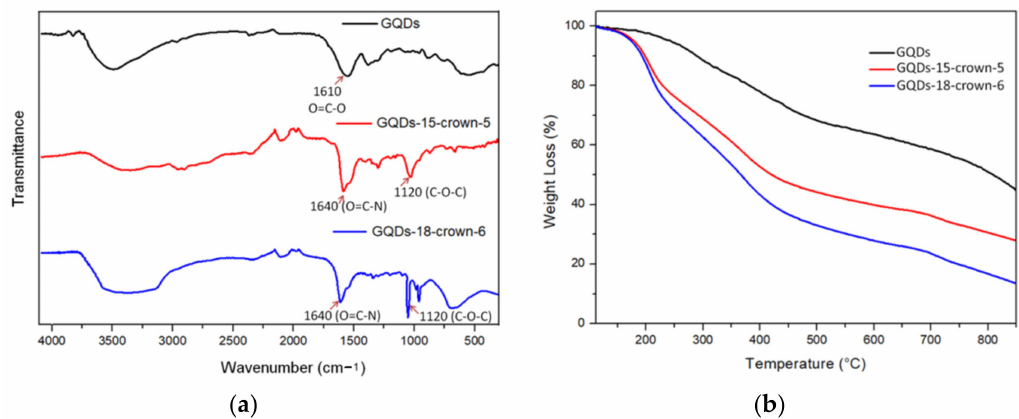
Figure 1. ( a ) FTIR spectra of the starting GQDs, GQDs-15-crown-5 and GQDs-18-crown-6; ( b ) TGA curves of GQDs, GQDs-15-crown-5 and GQDs-18-crown-6. All experiments were performed under Ar atmosphere.